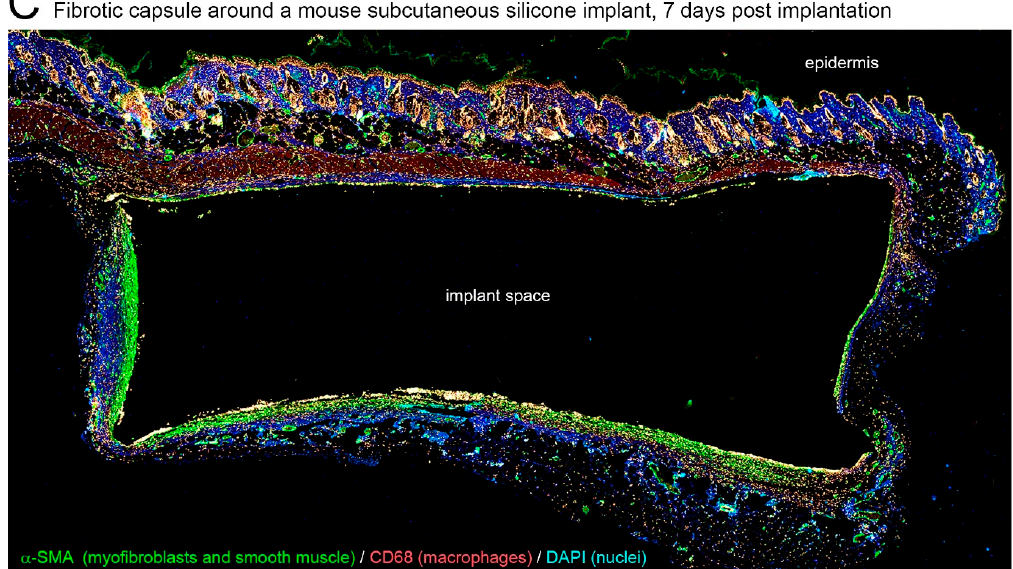
Figure 3. Myofibroblast mechanisms of fibrotic encapsulation of implanted stiff materials. ( A ) During the FBR, inflammatory cells secrete profibrotic cytokines which recruit fibroblasts to the implantation site. The stiff implant surface and surrounding extracellular matrix (ECM) mechanically activate fibroblasts into myofibroblasts at different levels. (1) Formation of focal adhesions with the ECM allows (2) formation of α -SMA-positive stress fibers and development of high contractile